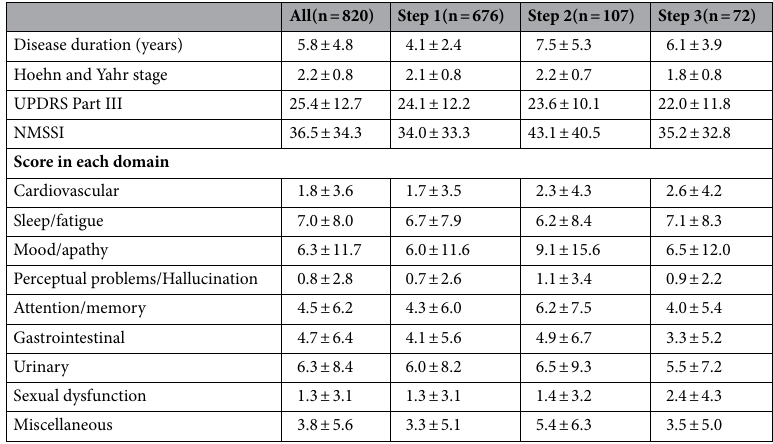
Table 1. Demographic data of total included patients and participants in each step. All data presented as mean ± standard deviation.